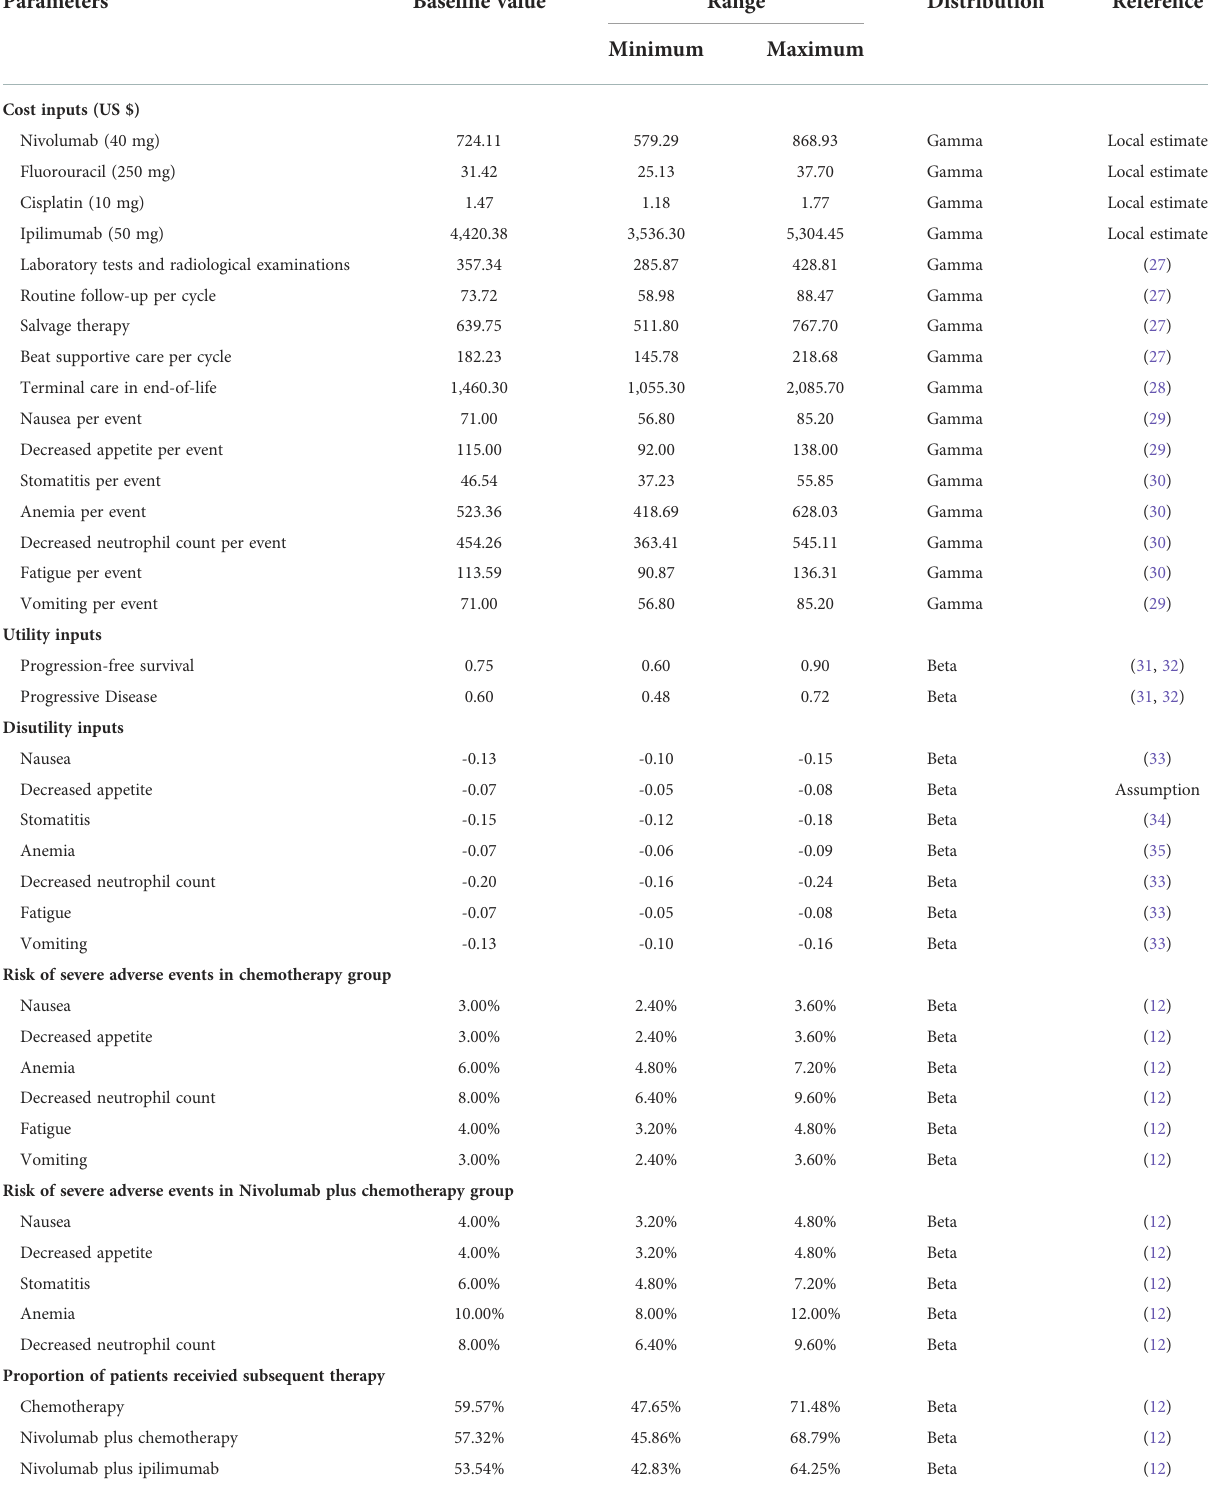
TABLE 2 Basic parameters input to the model and the ranges of the sensitivity